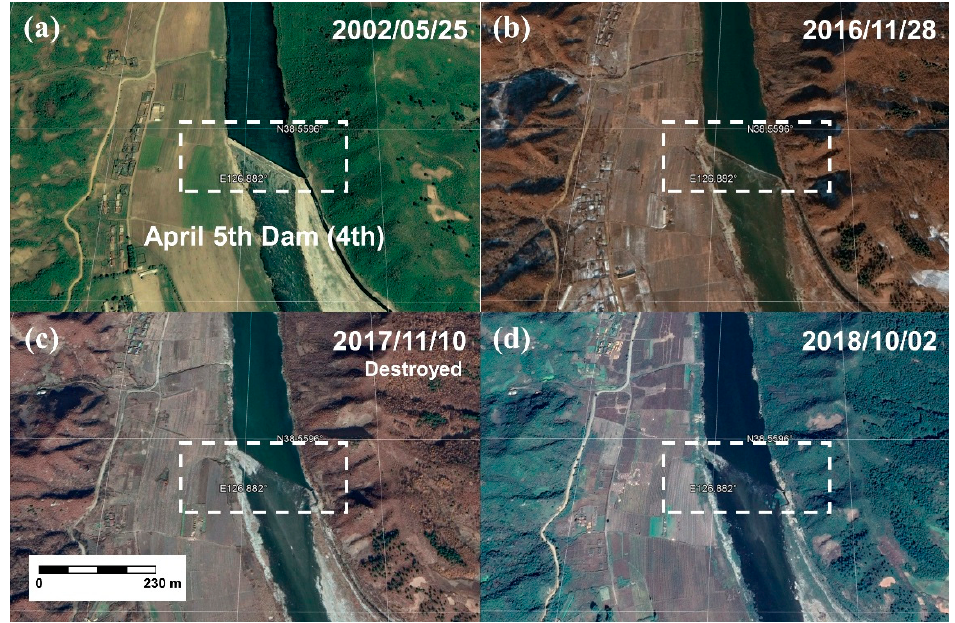
Figure 5. Images of the Fourth April 5th Dam from 2002 to 2018 (Lat 38.5588° N, Lon 126.8826° E, map data ©2019 Google, Maxar Technologies).